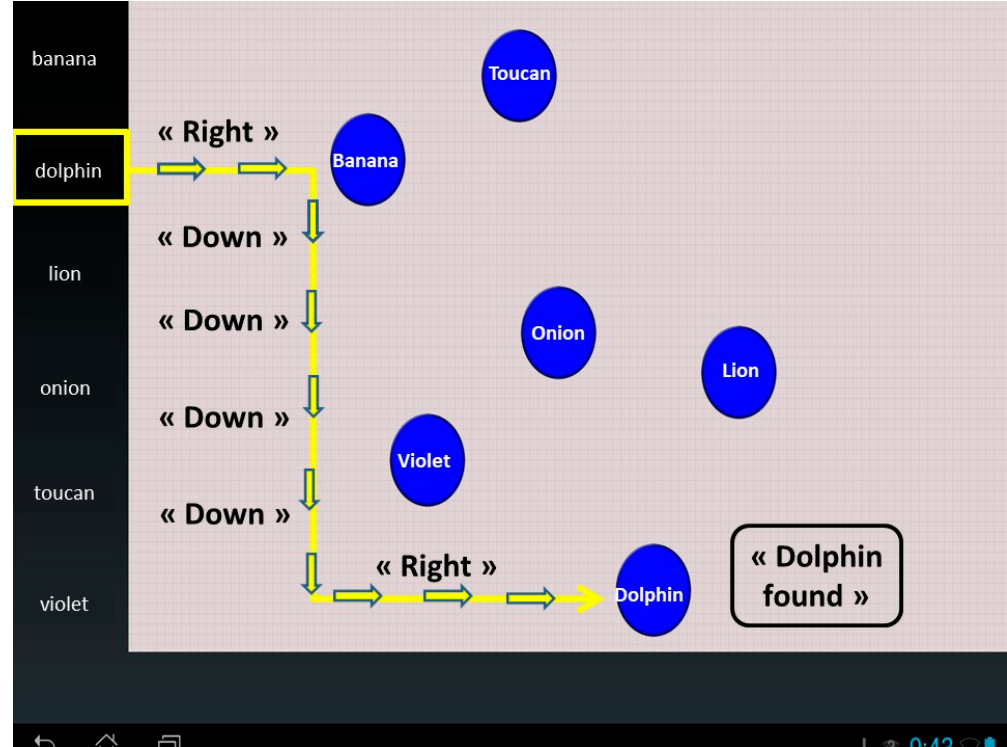
Figure 3. Schematic description of Direct Guidance Technique. Multimodal Technol. Interact. 2018 , 2 , x FOR PEER REVIEW